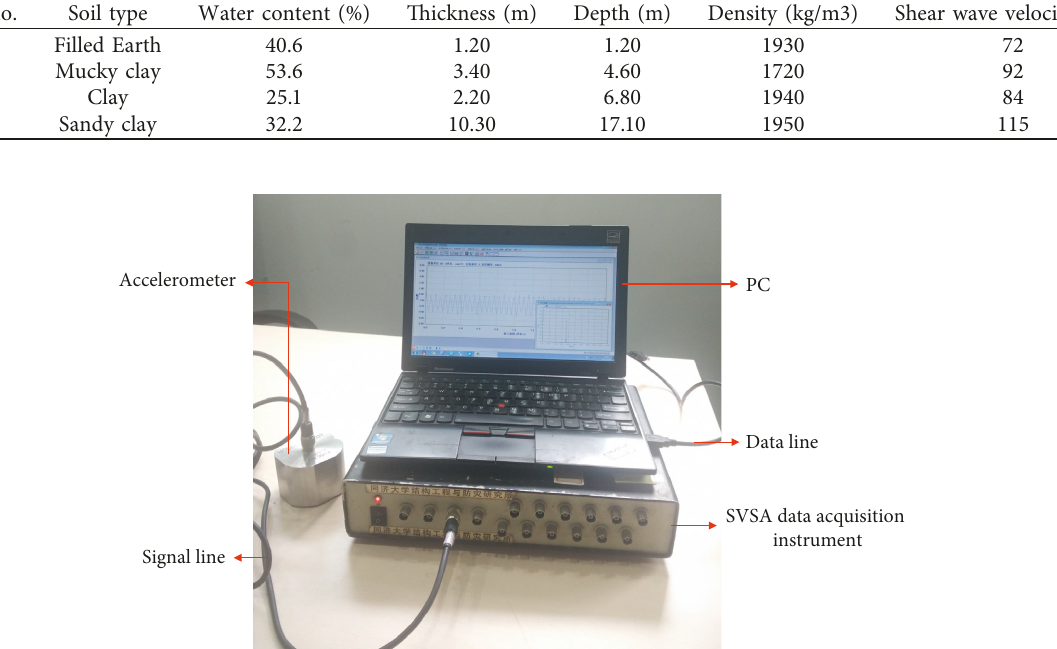
Figure 3: SVSA vibration test